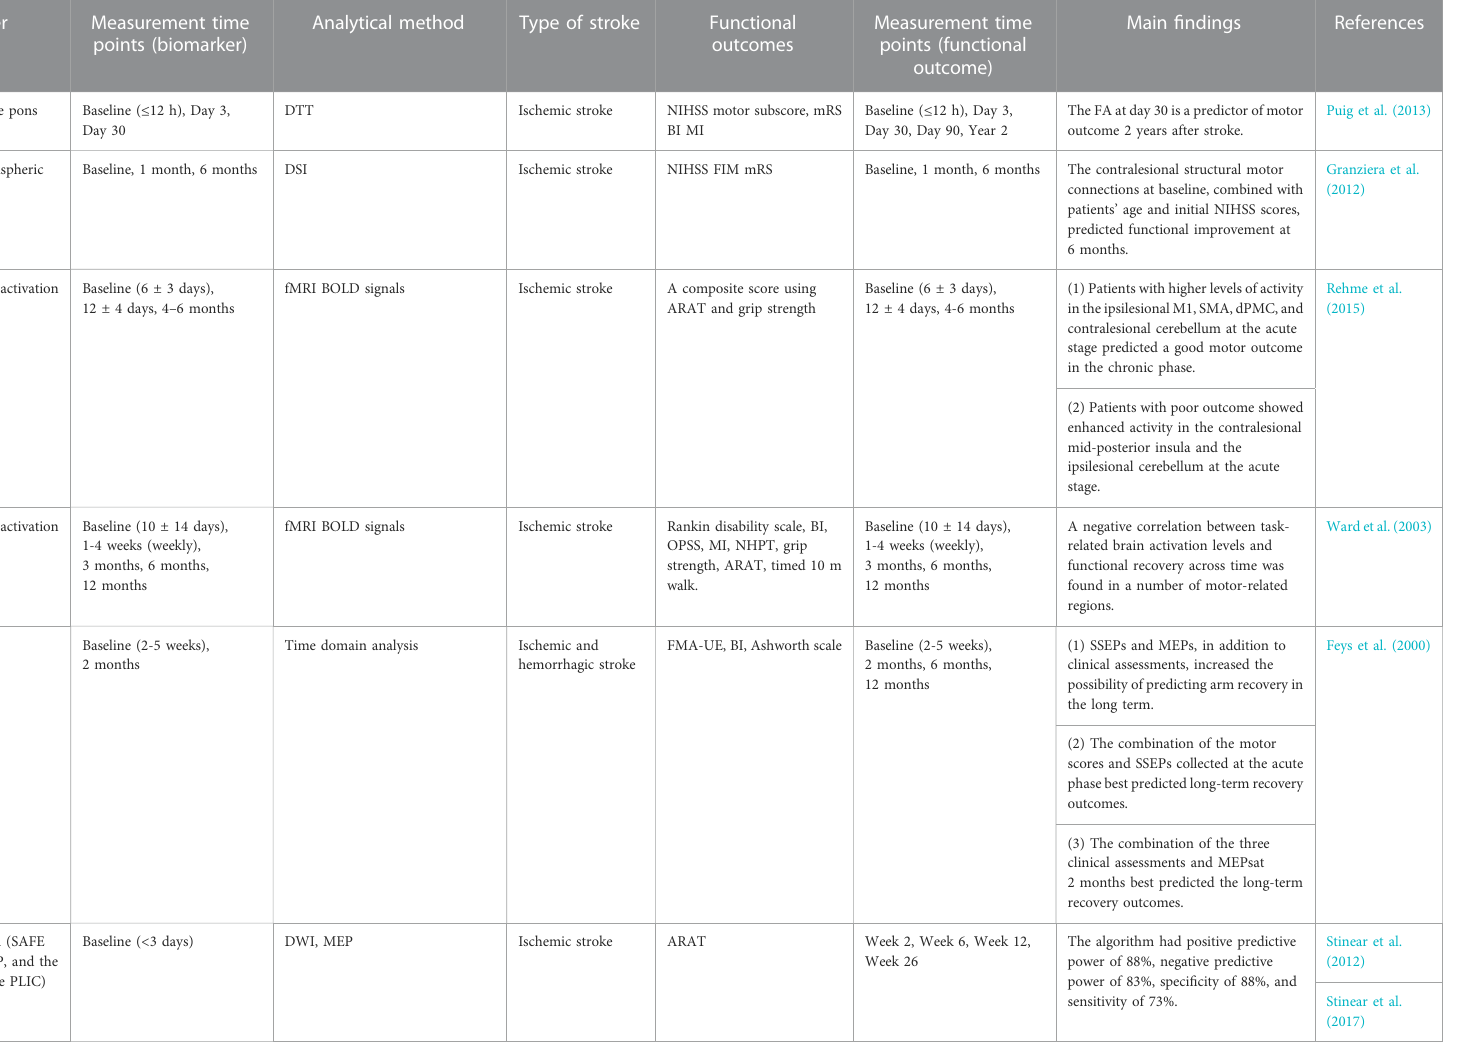
The PREP algorithm (SAFE scores in MRC, MEP, and